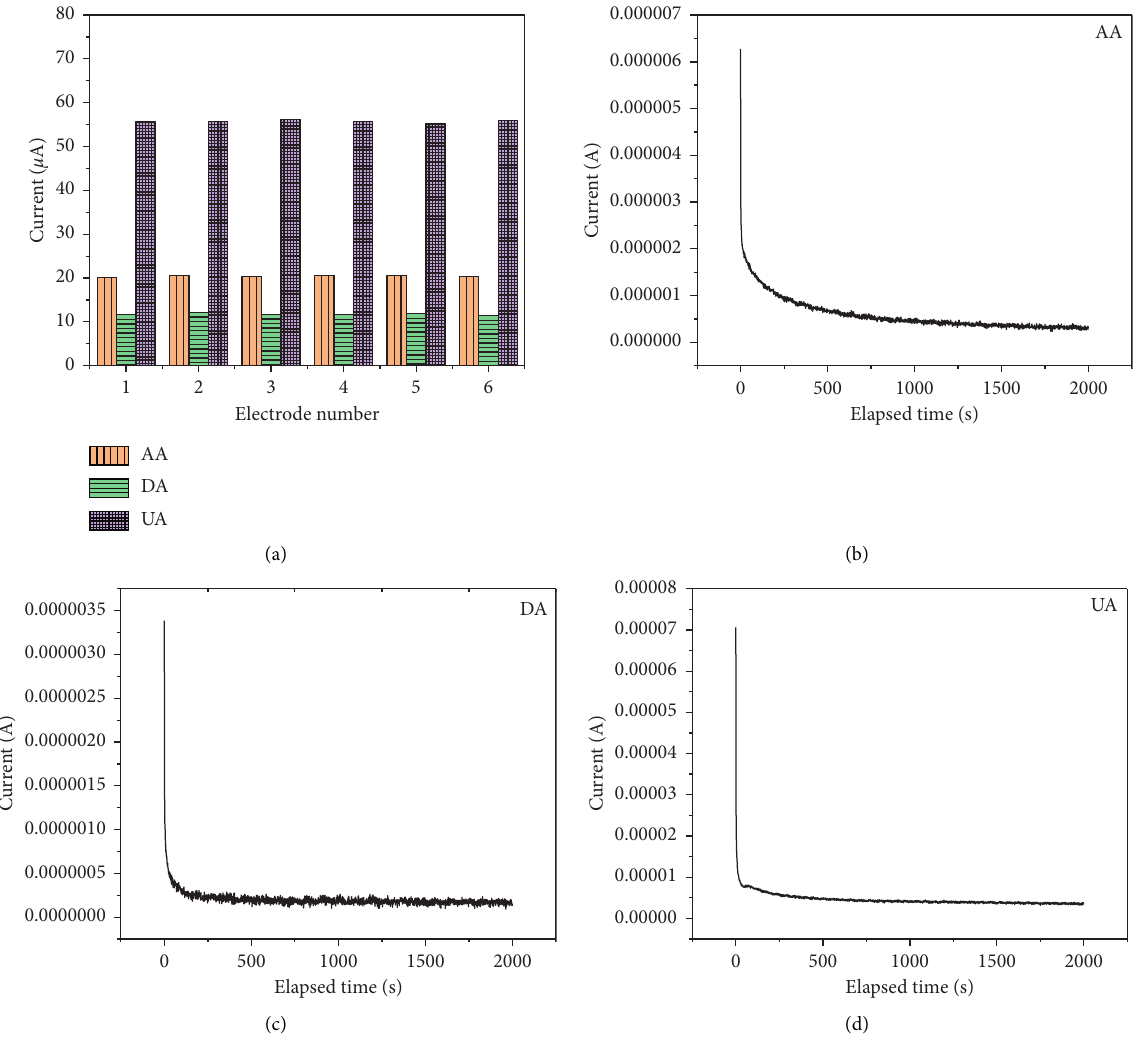
Figure 7: (a) Reproducibility of CQDs-rGO/GCE; stability of (b) 1mM AA, (c) 20 μ M DA, and (d) 0.5 mM